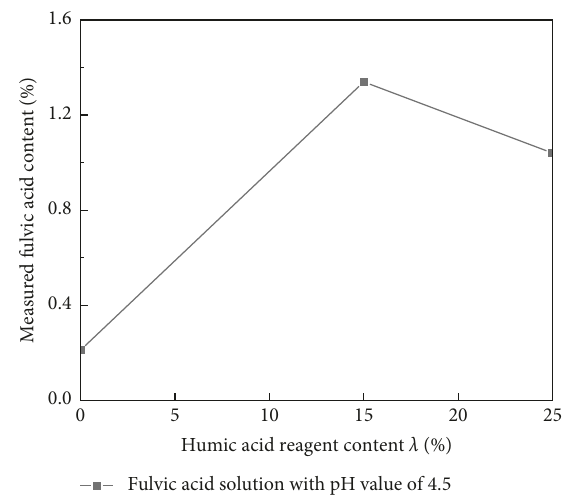
Figure 7: Relationship curve between measured FA content and HA reagent content of